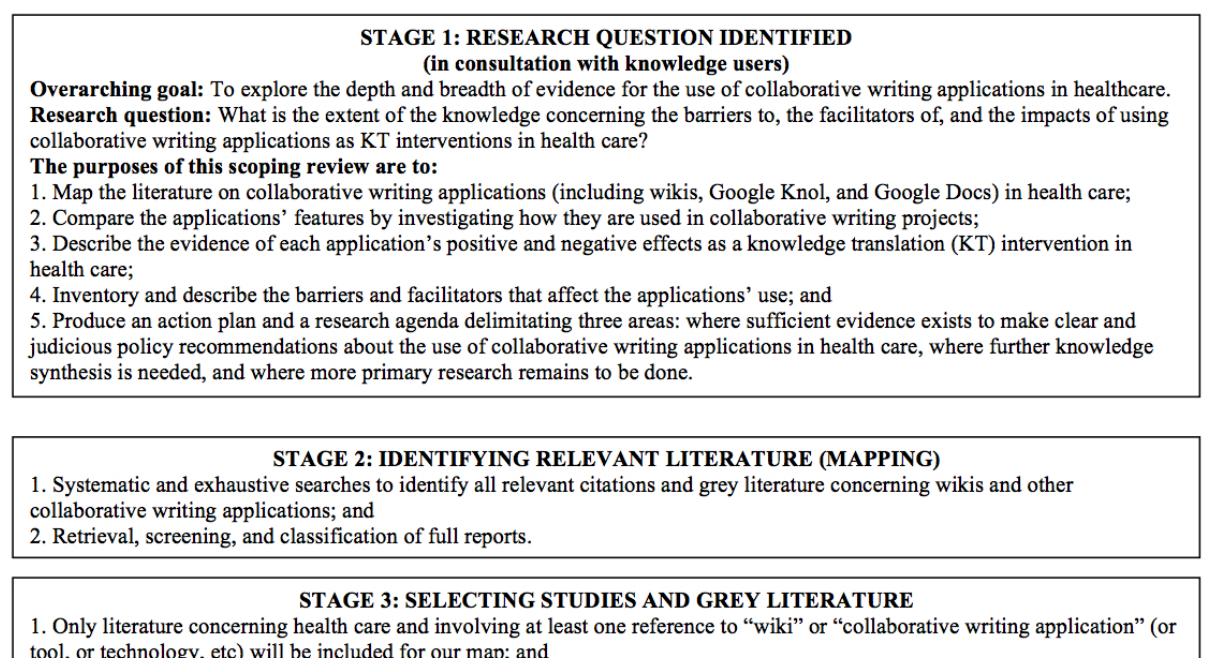
Figure 1. Stages of the scoping